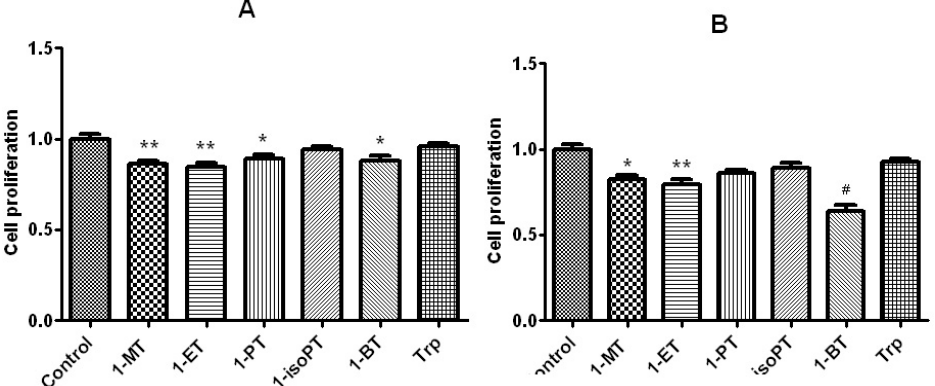
Figure 2. The effect of various concentrations of target compounds on HeLa cell proliferation. Cells were treated with various concentrations of compounds (A) 0.1 mmol/L (B) 0.5 mmol/L (C) 1 mmol/L (D) 2 mmol/L for 48 hours and the relative cell viability was determined by MTT. The values are expressed as mean ± SD of three determinations. * p < 0.05, compared with Trp. ** p < 0.01, compared with Trp. # p < 0.01, compared with any other